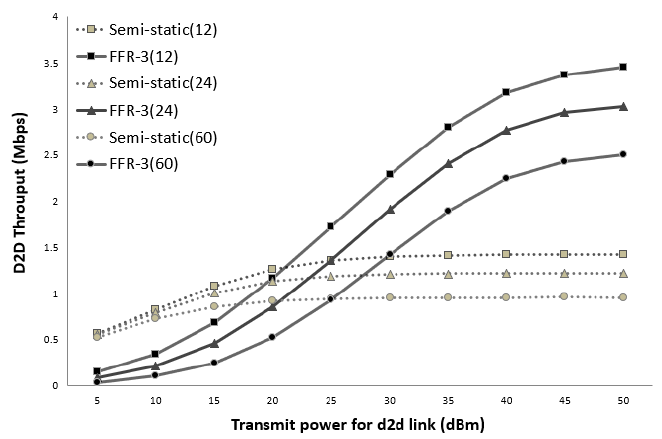
Figure 17. D2D link throughput versus D2D transmit power (cellular Tx power = 30